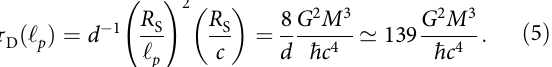
Fig. 2 The decoherence rate as a function of Δ x / R S . Note that this levels off for larger separations. Inset is the same function plotted on a log – log scale and showing the decoherence rates that correspond to black hole superpositions with separations of 1 cm if the black hole had the mass of the sun (shown with the yellow sun symbol ⊙ ), the earth (green earth symbol ⊕ ), and the moon (gray moon symbol ☾ ). The mass, Hawking temperature, and decoherence time for these cases are as follows. For the sun M ⊙ = 1.99 × 10 30 kg, T H ⊙ = 6.17 × 10 − 8 K, and τ D ⊙ = 7.52 × 10 9 s. For the earth M ⊕ = 5.97 × 10 24 kg, T H ⊕ = 0.0205 K, and τ D ⊕ = 2.07 × 10 − 7 s. For the moon M ☾ = 7.35 × 10 22 kg, T H ☾ = 1.67 K, and τ D ☾ = 1.09 × 10 − 11